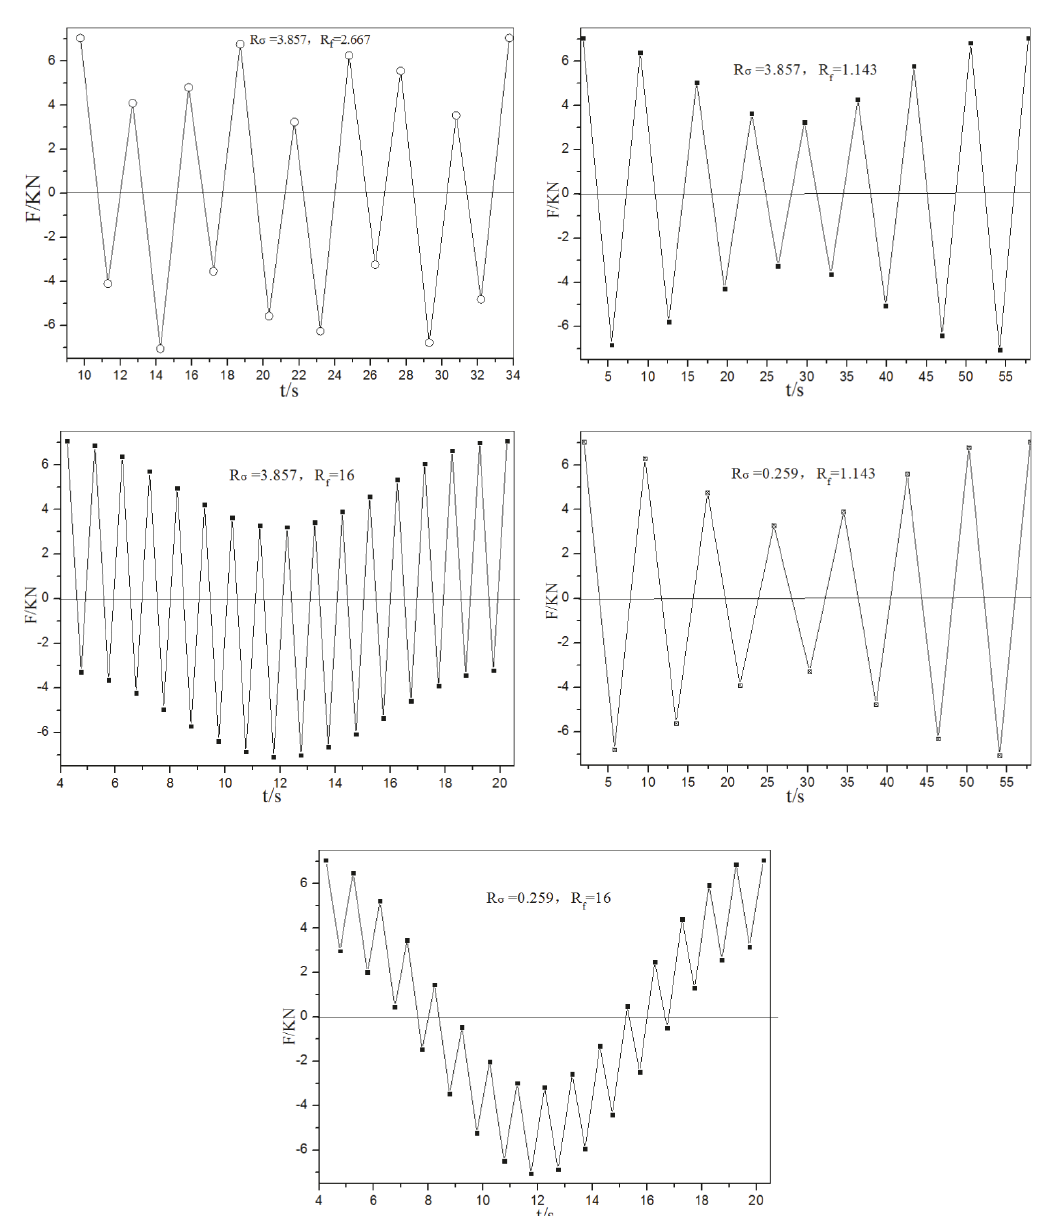
Figure 11: Simulated time history of combined process for experimental